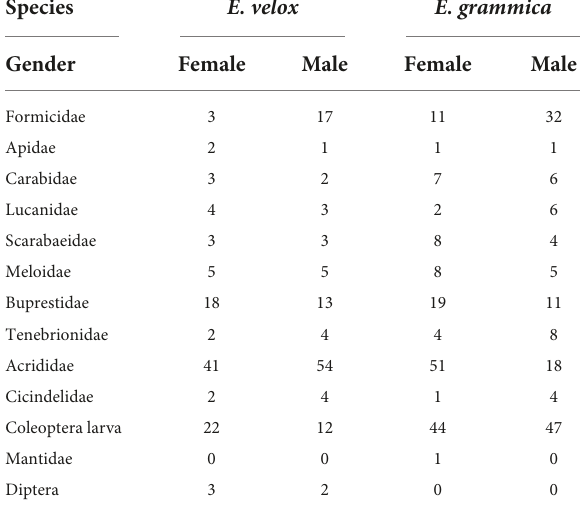
E. arguta , Liang et al., 2018) exhibited territorial behaviors (e.g., male–male competition) during our field observations.